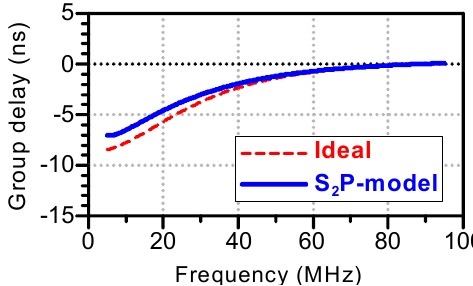
Figure 3: Comparison of the group delay frequency responses from ideal RF circuit and realistic circuit with S2P models including the bias networks.